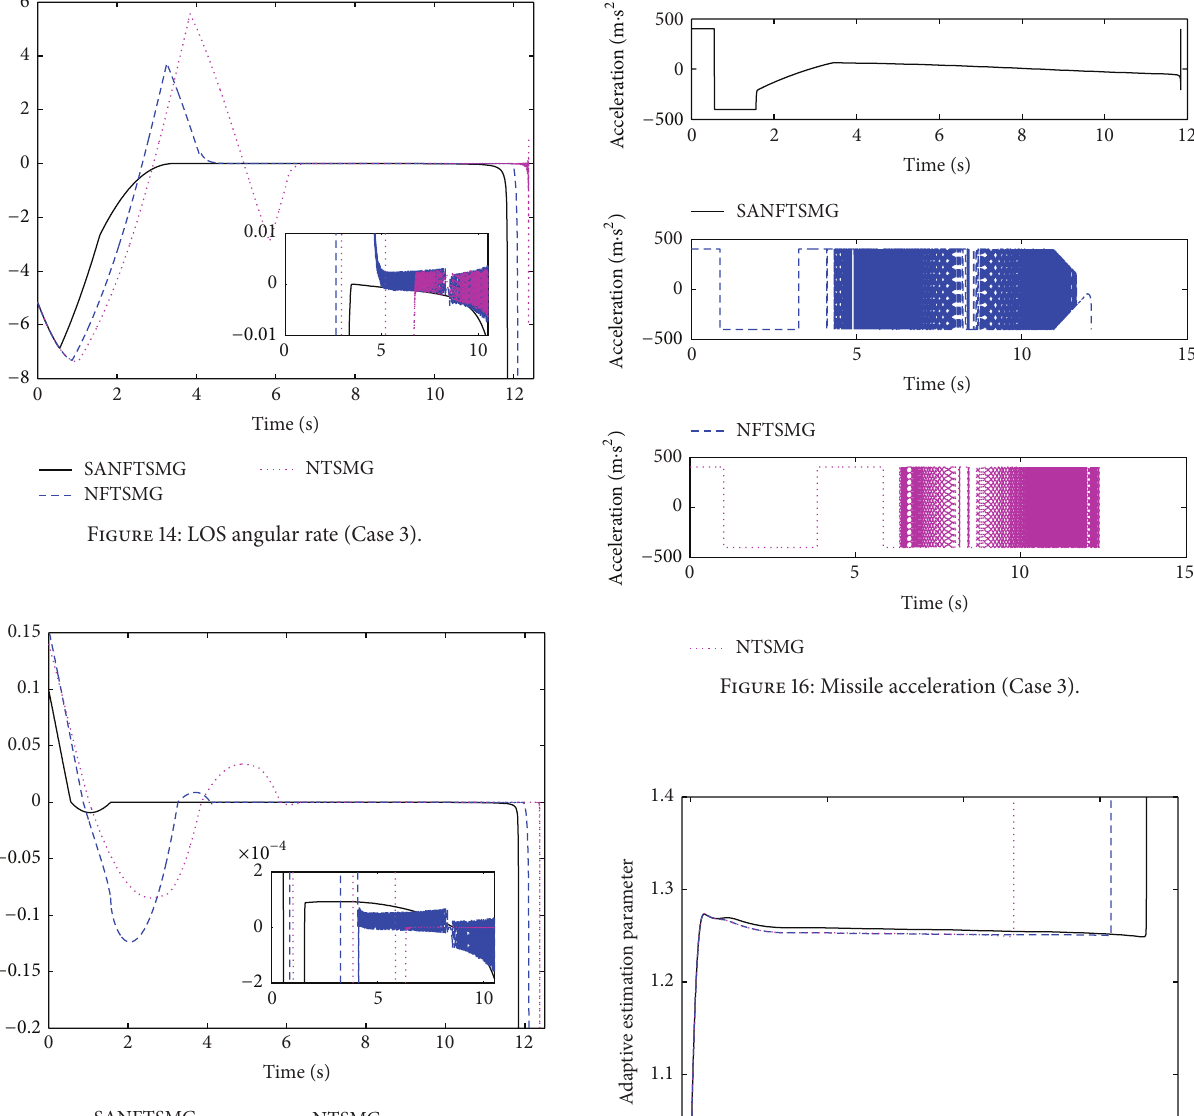
Figure 15: Sliding mode manifold (Case 3).